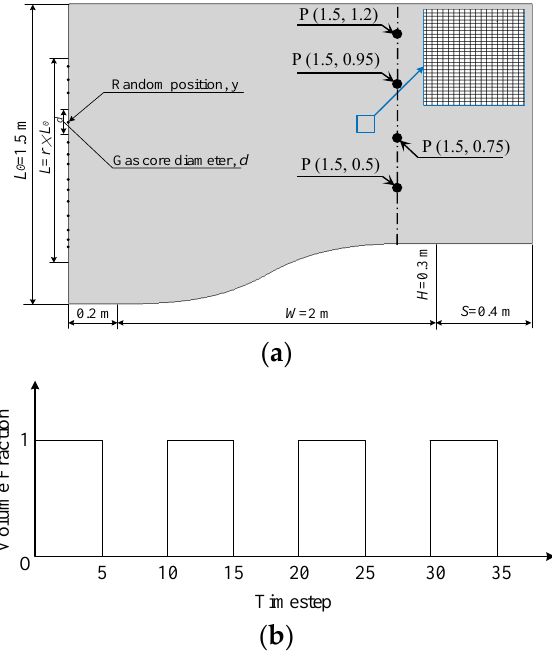
Figure 1. Calculation model for CFD simulations. ( a ) Mesh and geometric parameters of the CFD model; ( b ) time-dependent control function of the bubble volume fraction.